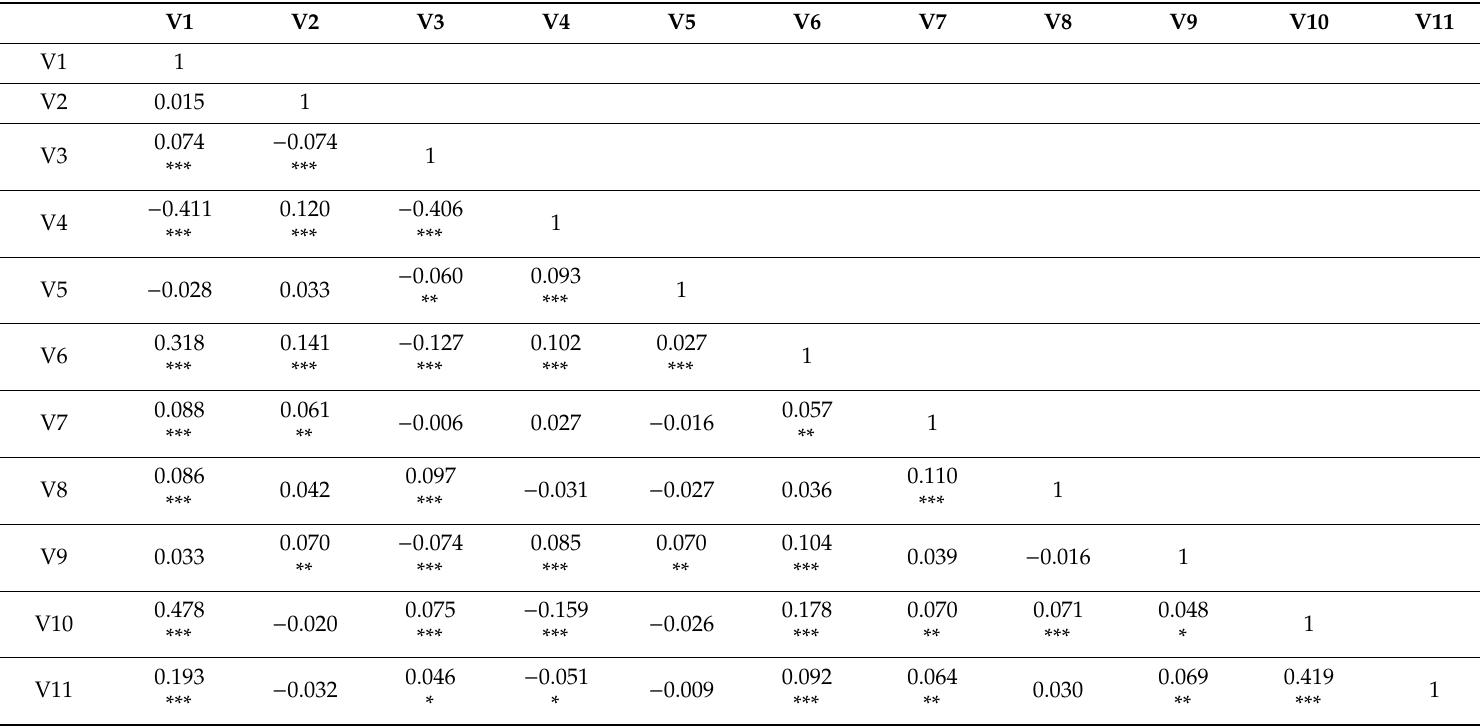
Table 3. Correlation matrix (Unit: million